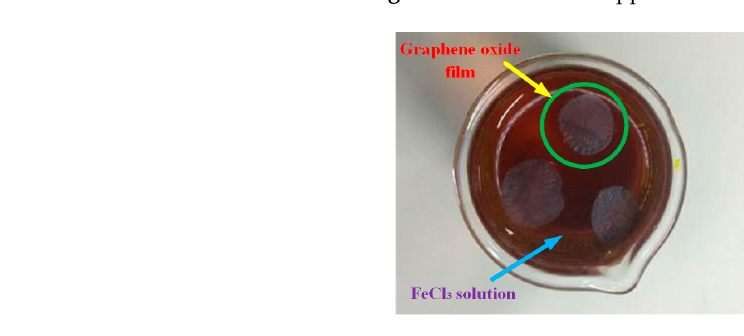
Figure 5. Unsupported GO films.